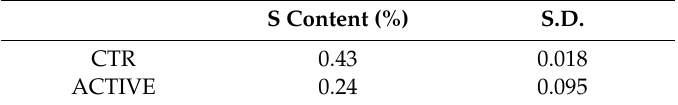
Table 1. Atom % of sulfur on the control disk and on the disk with the